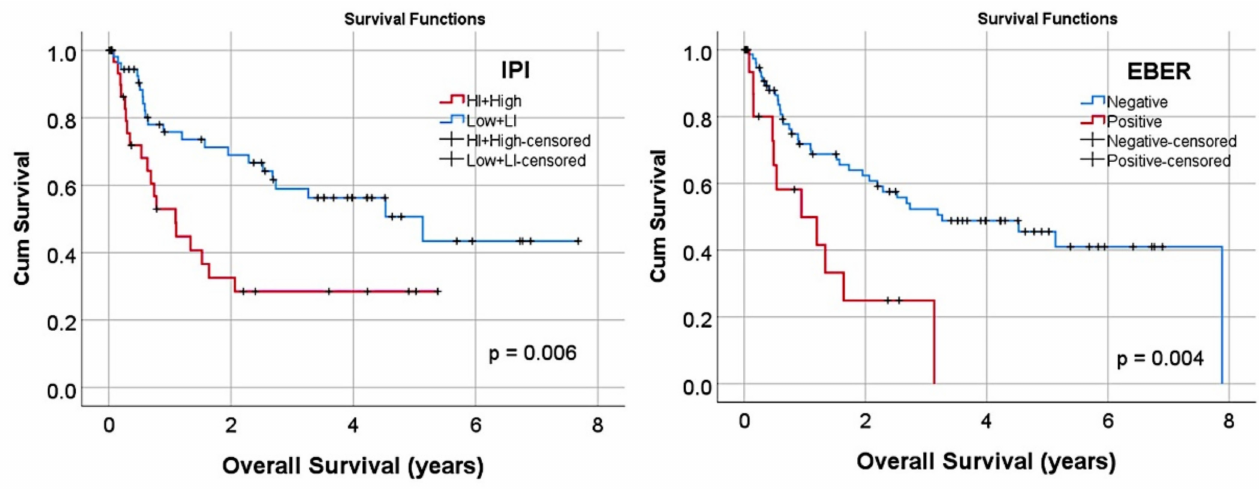
Figure 1. Overall survival according to the international prognostic index (IPI) and Epstein–Barr virus infection (EBER). Cases with IPI high–intermediate/high and EBER positivity were associated with poor overall survival ( p <